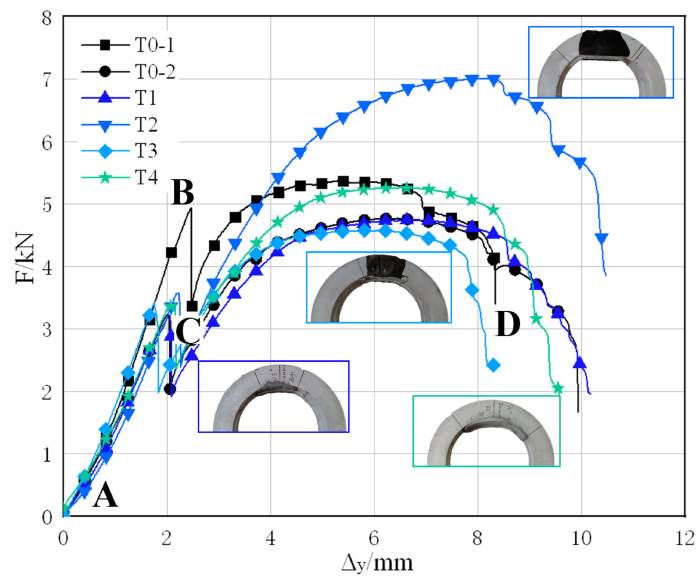
Figure 10. Load-displacement curves of TEBTs. (AB. Initial deflecting; BC. Pipe collapse; CD. Plastic